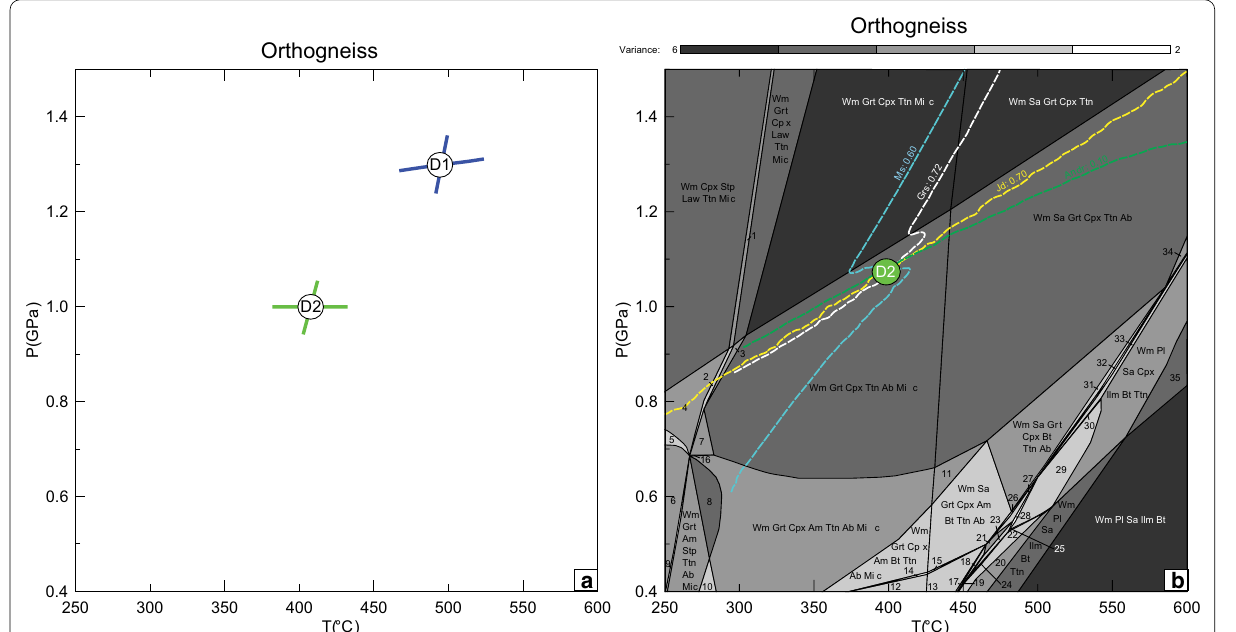
Fig. 14 a PT conditions of D1 (blue) and D2 (green) events (Table 8) estimated from quantitative image-assisted calibrated independent thermometers and barometers for orthogneiss. b Pseudosection calculated in the Na 2 O–TiO 2 –MnO–K 2 O–MgO–FeO–Fe 2 O 3 –CaO–Al 2 O 3 –SiO 2 –H 2 O system for orthogneiss and PT conditions of D1 (blue) and D2 (green) events (Table 8) estimated from the intersections of garnet end-members isopleths (grossular-white; andradite-green), white mica (muscovite-turquoise) and clinopyroxene (jadeite-yellow). The assemblage lists are reported in the Additional file 1: